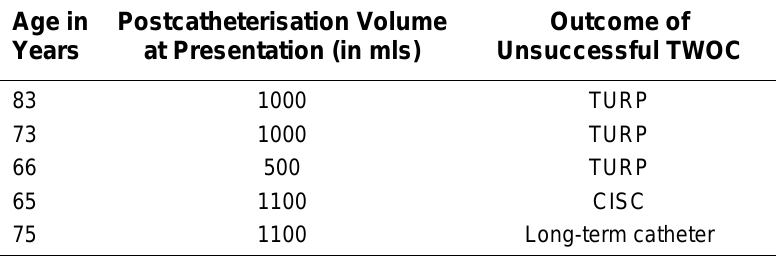
Unsuccessful TWOC in Relation to Age and Postcatheterisation